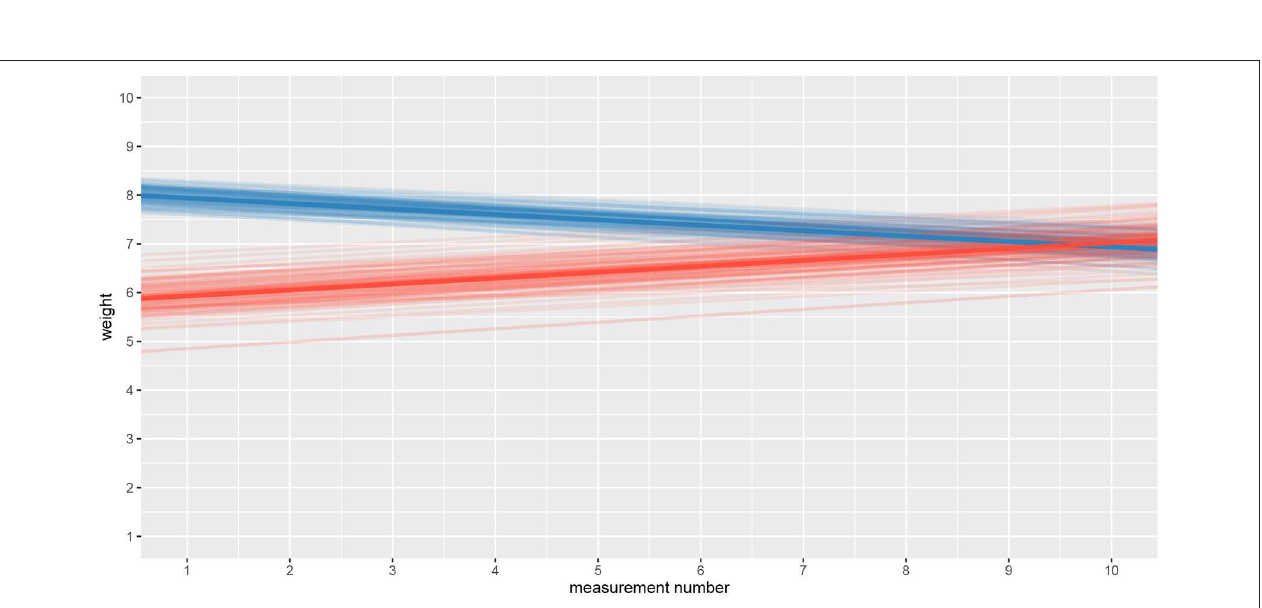
level phenomenon fades away with time. We can visualize this by plotting means and distributions underlying both fits. The plotting functions in the bayes4psy package return regular ggplot2 plot objects, so we can use the same techniques to annotate or change the look and feel of graphs as we would with the usual ggplot2 visualizations (see the code below and Figure 12 ).